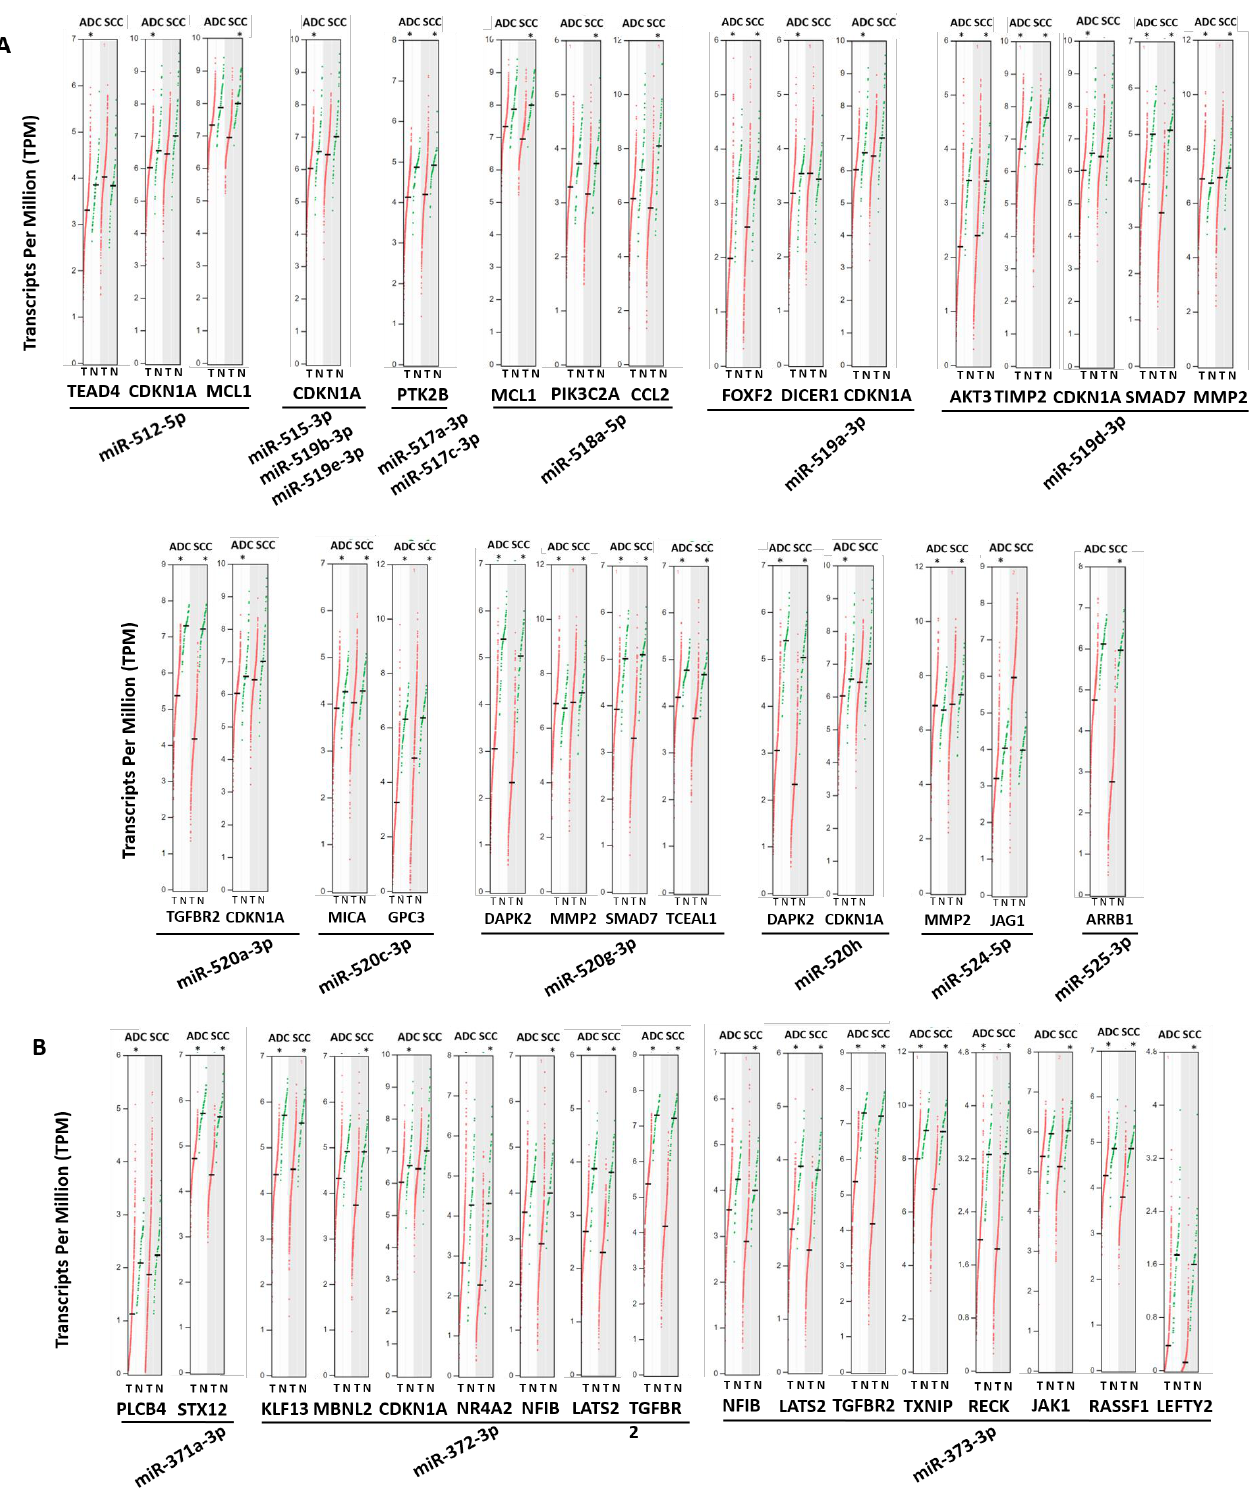
Figure 5. Transcripts per million (TPM) in normal (green) and tumor (red) lung tissues of those genes identified as strongly validated miRNA targets. ( A ) C19MC cluster and ( B ) MIR371-3 cluster. T: Tumor Tissue; N: Normal Tissue; ADC: Adenocarcinoma Lung; SCC: Squamous Cell Carcinoma. * ANOVA test with p -value < 0.01.